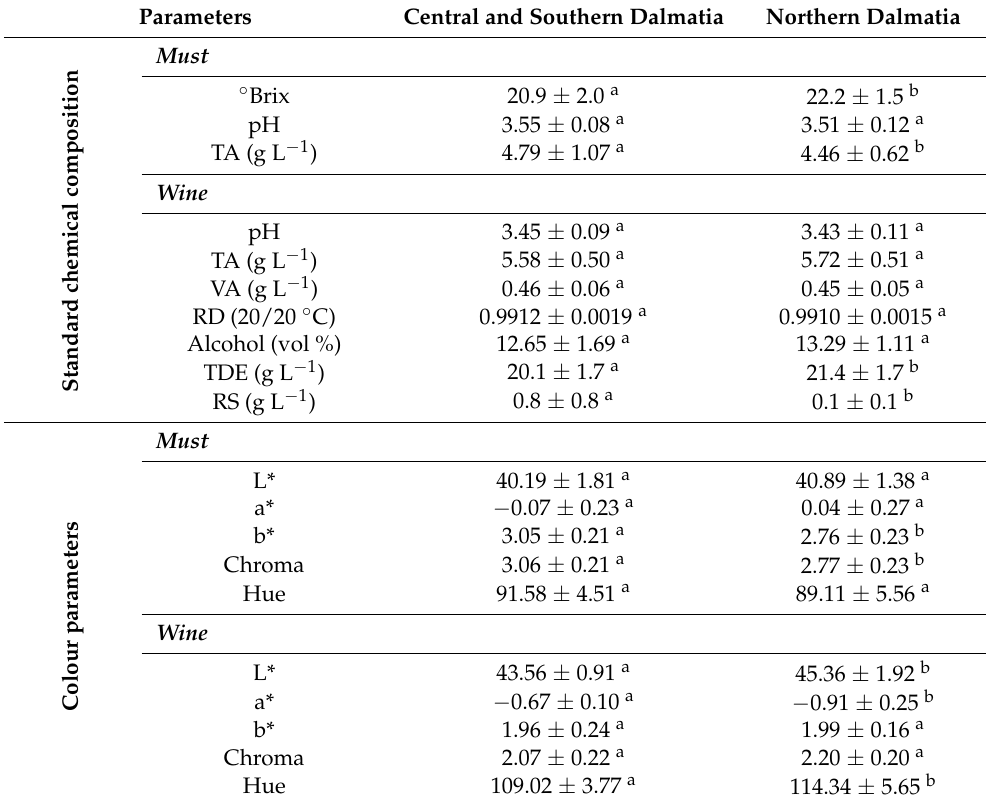
Table 1. Standard physicochemical and colour data (mean ± standard deviation) of must and wines produced from grapes of the Maraština variety grown in 10 different vineyards. Different letters in the same row denote significant differences at p <